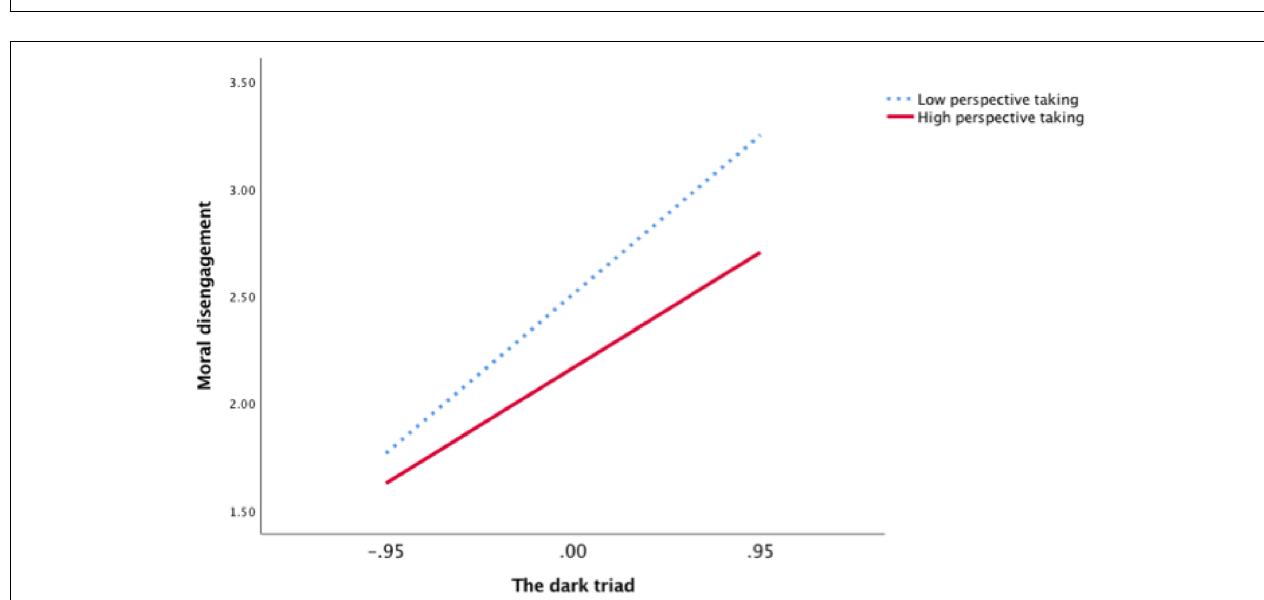
FIGURE 5 | The moderation effect of perspective taking in Study